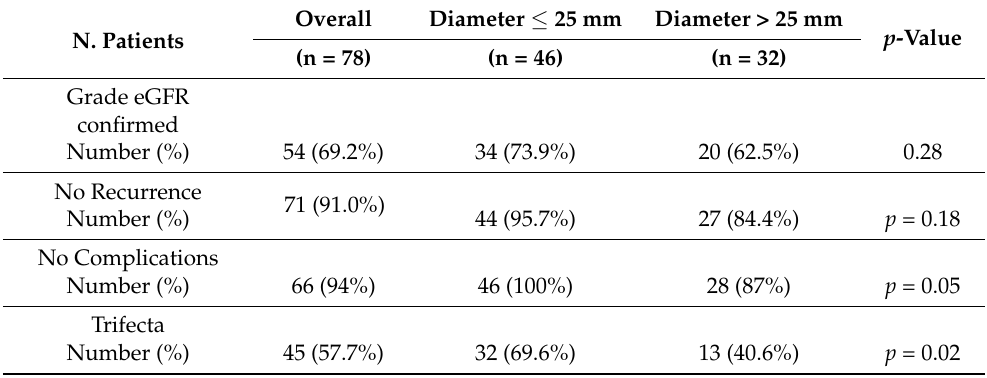
Table 4. Trifecta outcome between the two groups. N.